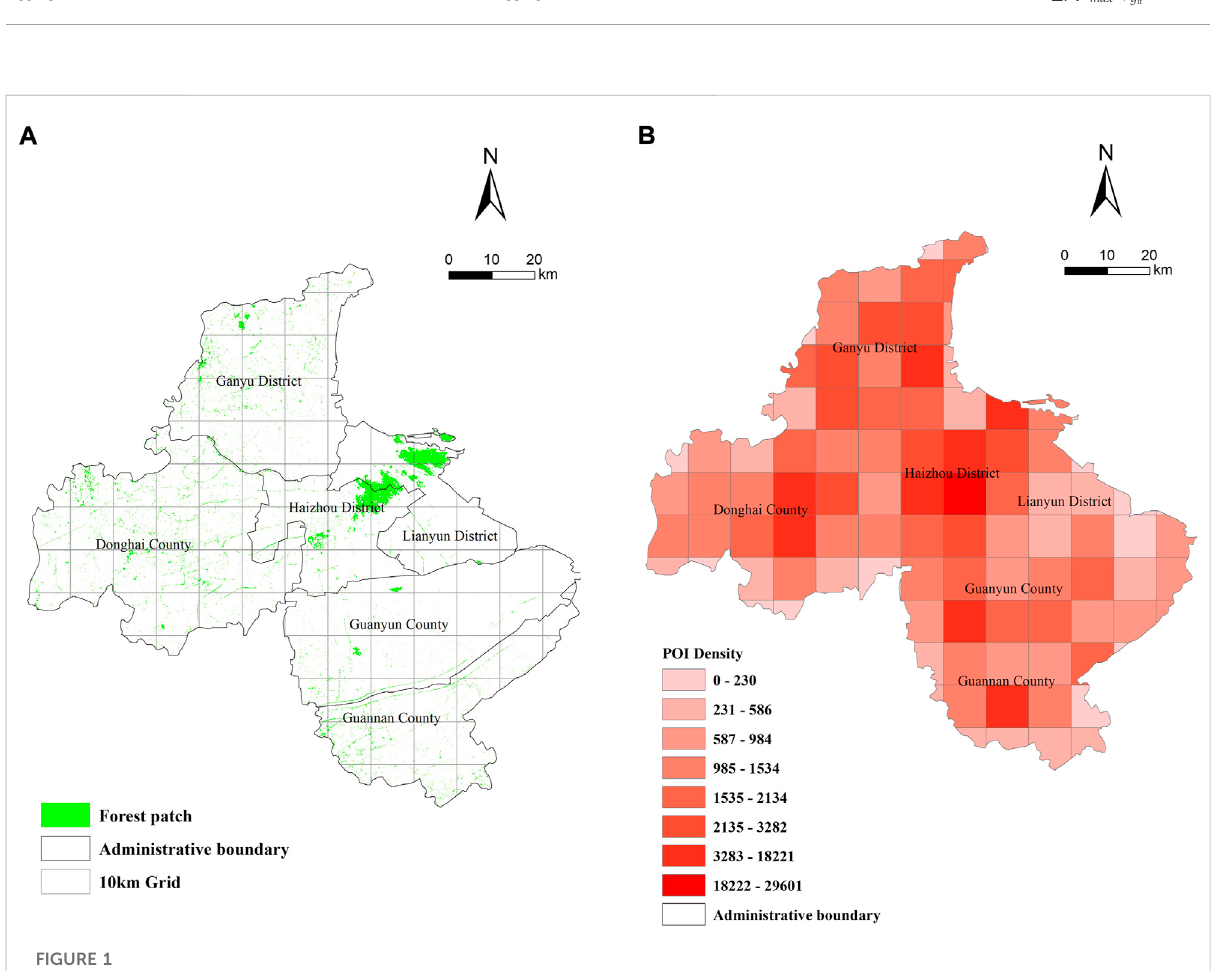
FIGURE 1 Spatial distribution of urban forests and POI. (A) Urban Forests, (B)